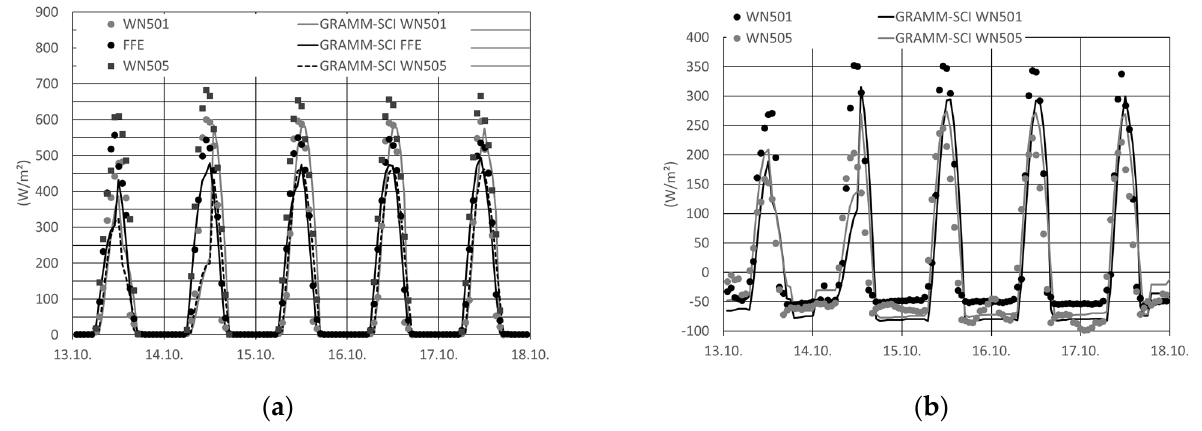
Figure 4. Observed and modelled global radiation ( a ) and net radiation ( b ) at selected sites.